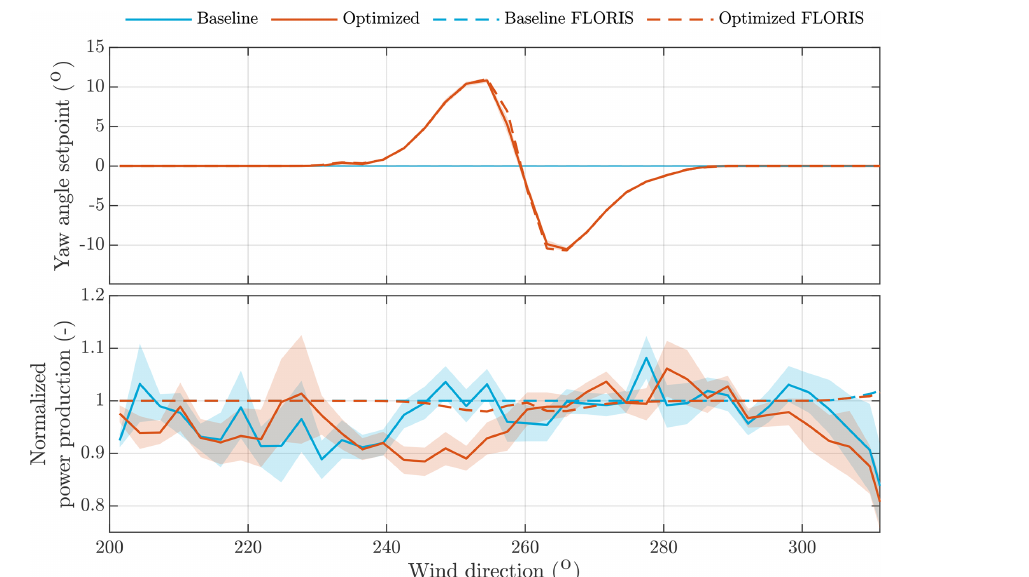
Figure 8. Yaw misalignments and corresponding power production for WTG 26, normalized with respect to WTG 25. The shaded areas show the 95% confidence bounds. The dashed lines represent the predictions for the measured inflow conditions by FLORIS. The number of samples in each bin is shown in Fig.